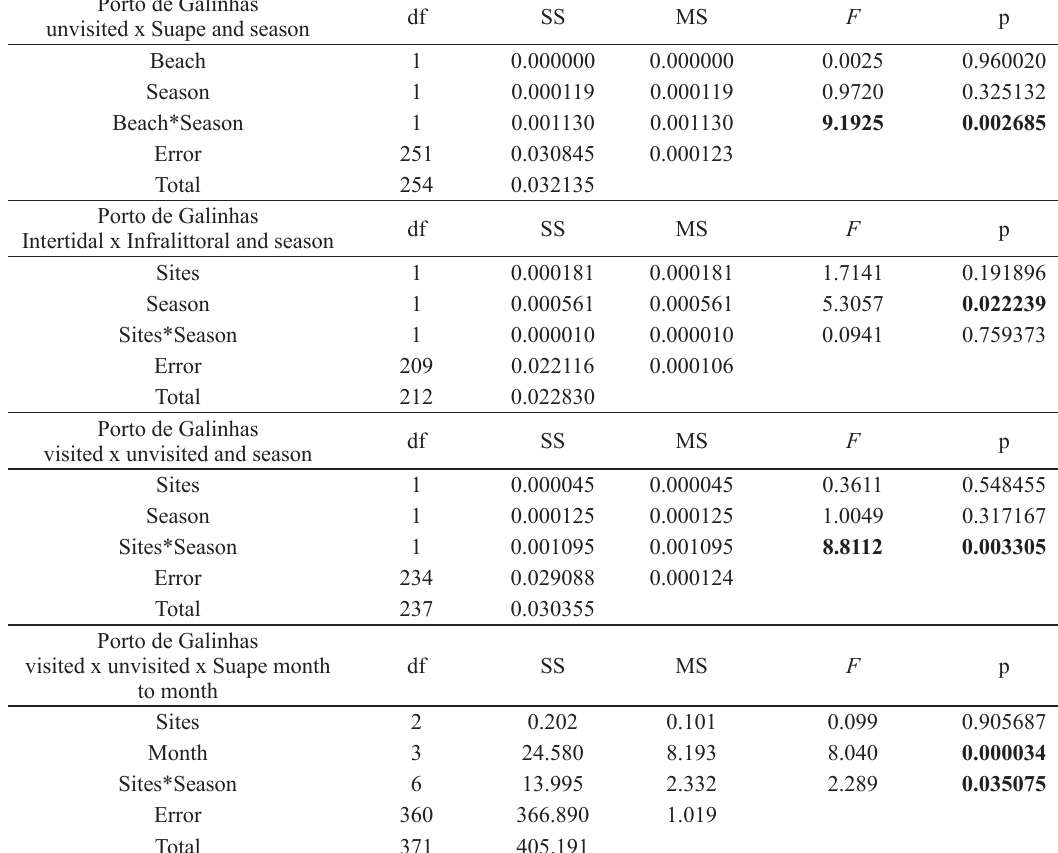
GLM model results of each of the three dependent variables (Beach, Sites and Season) on the Palythoa caribaeorum growth rate. Significant results in bold. df, degrees of freedom; SS, sum of squares; MS, mean